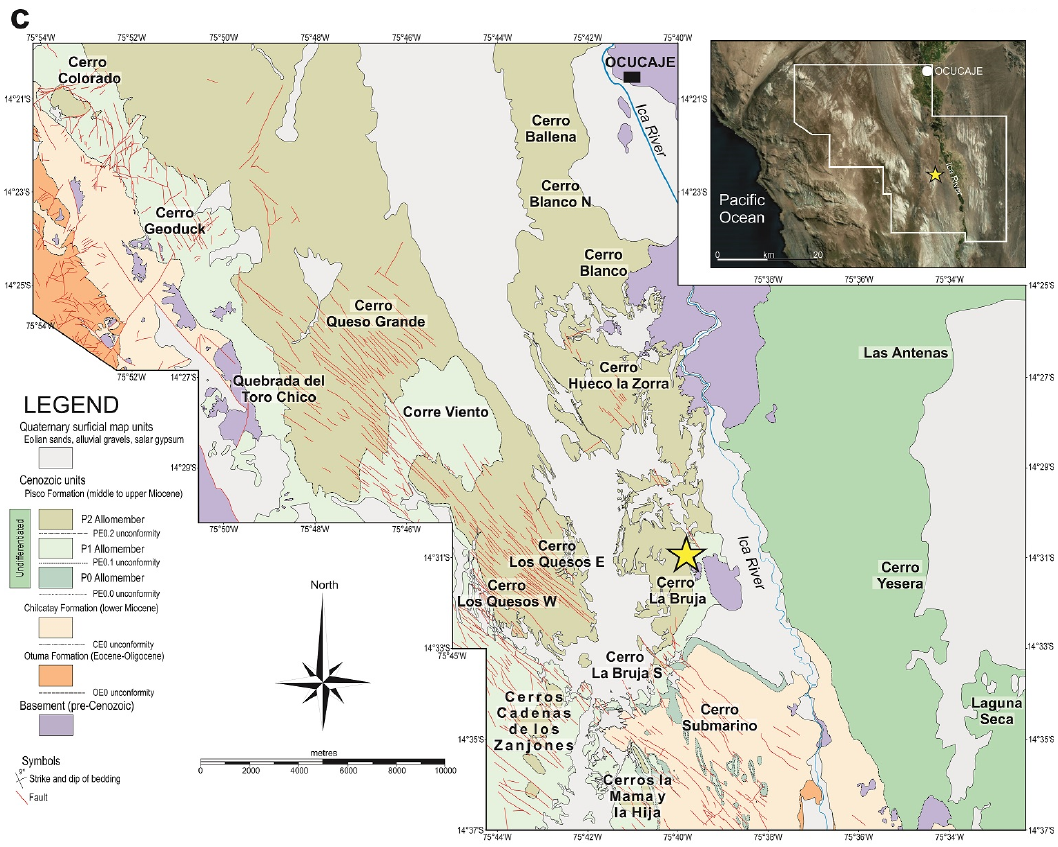
Figure 1. Geographic and geological setting. ( a ) Map of the major Cenozoic sedimentary basins along the coast of Peru. Redrawn and modified from Travis et al. [41] and Thornburg and Kulm [42]. ( b ) Schematic stratigraphic column of the Middle to Upper Miocene succession exposed in the East Pisco Basin and its internal subdivision into sequences/allomembers and facies associations. Redrawn and modified from Di Celma et al. [43]. ( c ) Geological map of Cerro La Bruja and surrounding areas. Redrawn and modified from Di Celma et al. [39]. The stars in panels ( b , c ) indicate the occurrence of the fragmentary turtle carapace MUSM 4716. Abbreviations: amb, allomember; Fm, Formation.